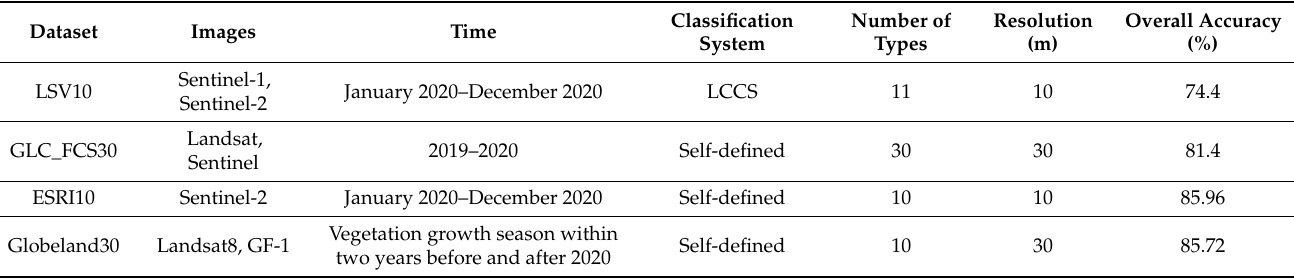
Table 1. Information about the source datasets.